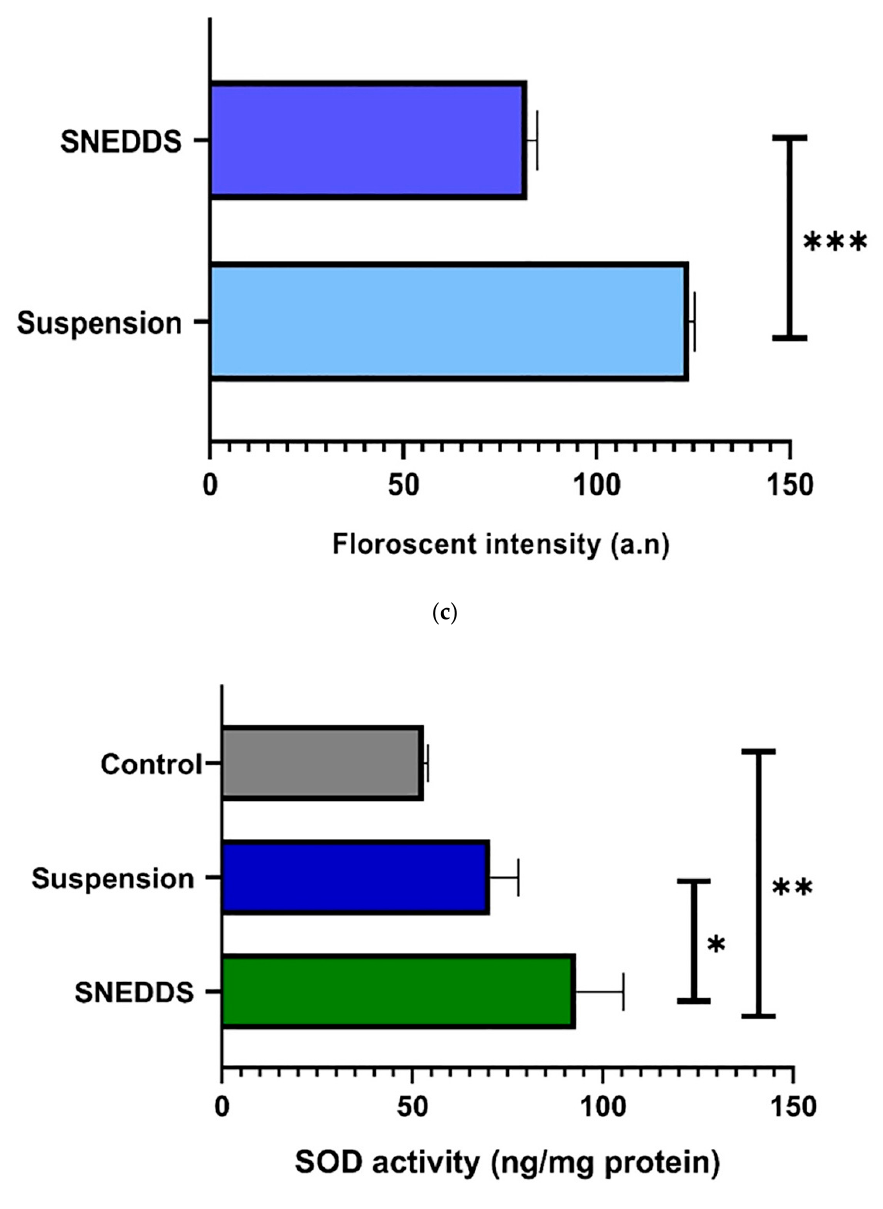
Figure 9 . In vitro cell line study showed the ( a ) cytotoxicity of TAM-RES-s-SNEDDS and suspension after incubation with MCF-7 cell. ( b ) Fluorescent microscopic images of MCF-7 after incubation with A. SNEDDS, B. Suspension. ( c ) ROS level in MCF-7 after incubation with SNEDDS and suspension using DCFDA technique. ( d ) The SOD activity in MCF-7 after incubation with SNEDDS, suspension and control. Data are given as mean ± standard deviation ( n = 3) with statistical difference at (*) p < 0.05, (**) p < 0.01 and (***) p < 0.001.